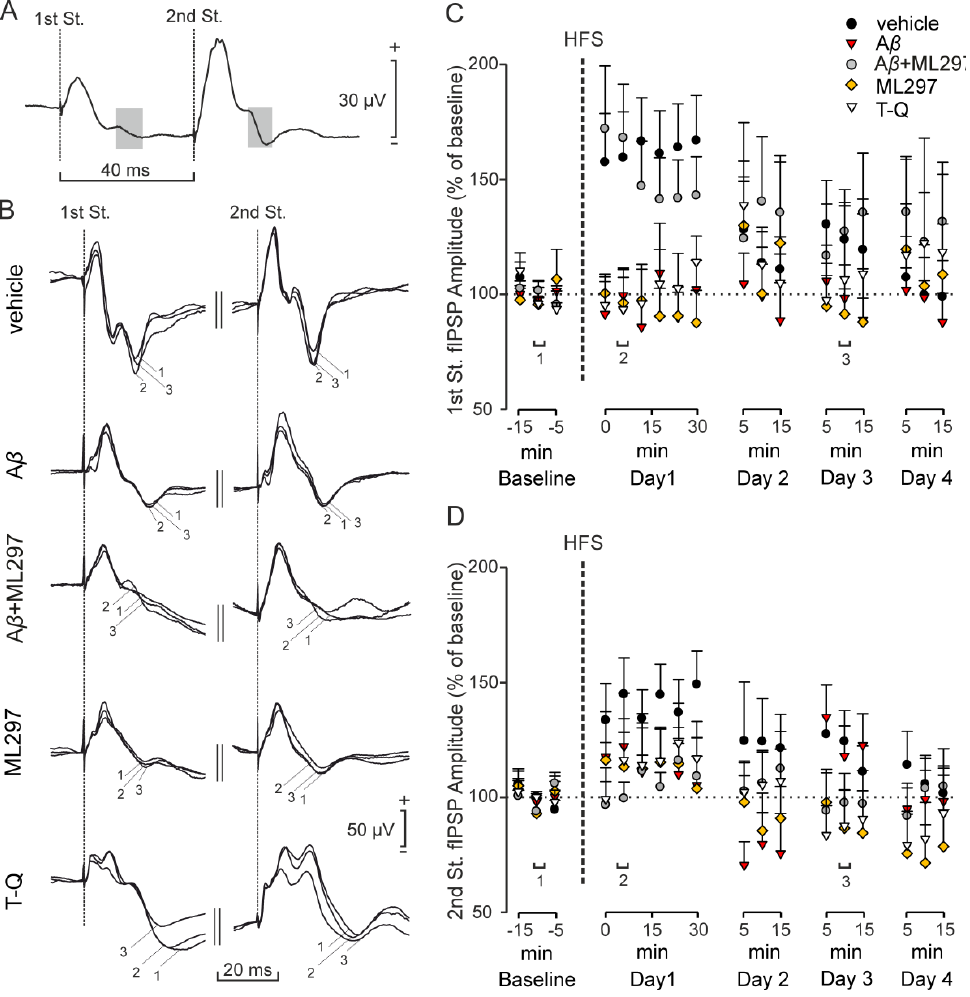
Figure 4. Evolution of the GABA A receptor-dependent fIPSPs evoked in the CA1 area by stimulation of the Schaffer collaterals after an HFS session. The same intensity of stimulation was used before (baseline) and after the HFS protocol, and the amplitude of the ionotropic fIPSPs was